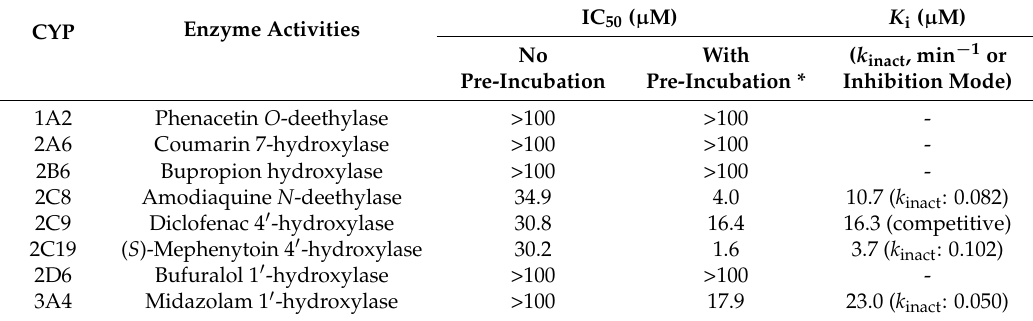
Table 1. Inhibitory effect of fargesin on eight major CYP enzyme activities in pooled human liver microsomes.